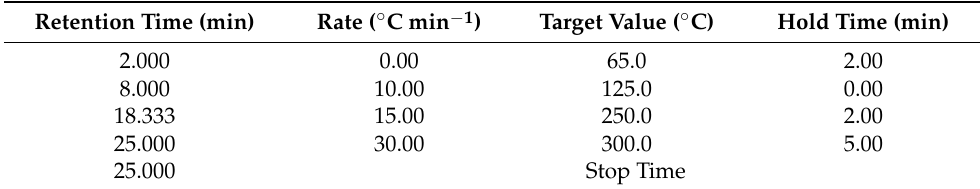
Table 6. Gas chromatography oven temperature